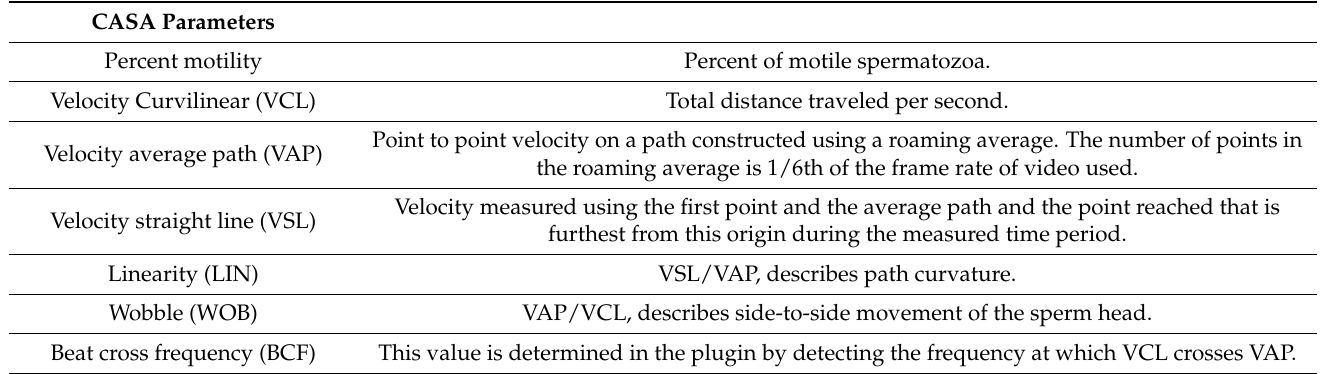
Table 2. Parameters measured by CASA